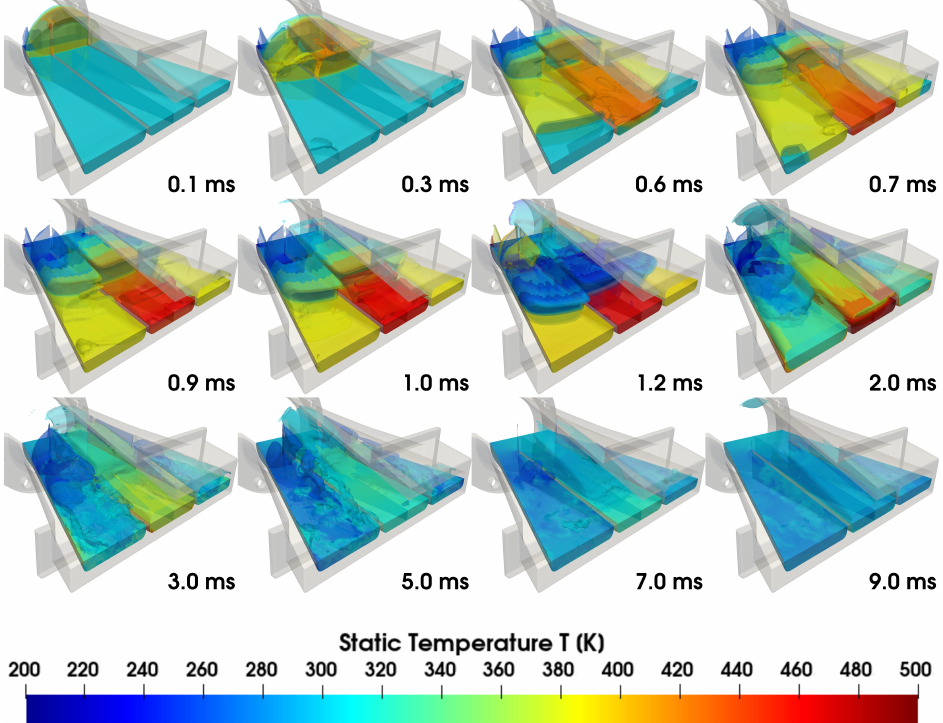
Figure 16. Snapshots of temperature contour plots for 12 time